Question: Briefly state, in one sentence, what is plotted here.
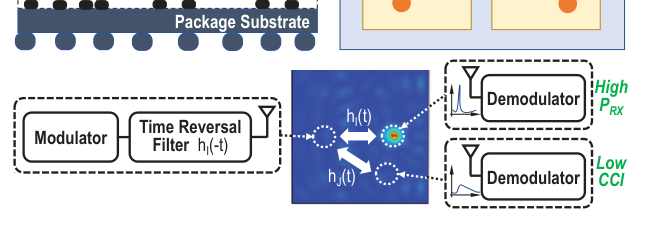
Answer: Interposer package with four chiplets and multiple wireless chips-scale links. With time reversal, the transmitted signal is spatiotemporally focused at the intended receiver, achieving high power with a short response. At non-intended receivers, the co-channel interference (CCI) level is dimin- ished.